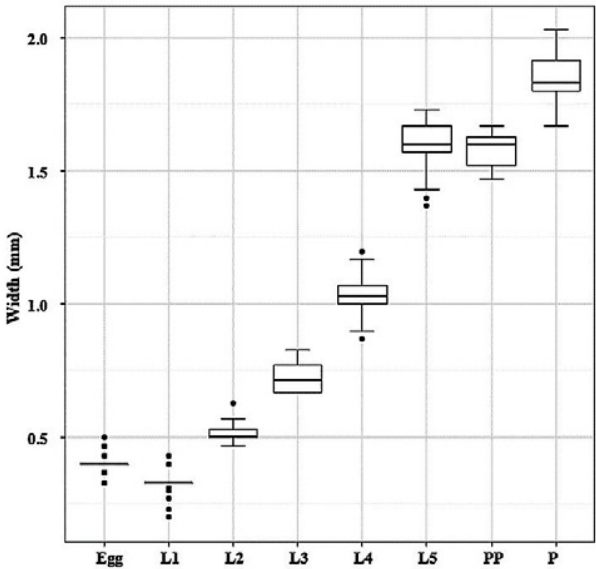
cephalic capsules of the larvae (L1 – L5), pre-pupae (PP), and pupae (P) of Mischocyttarus nomurae (Hymenoptera: Vespidae).